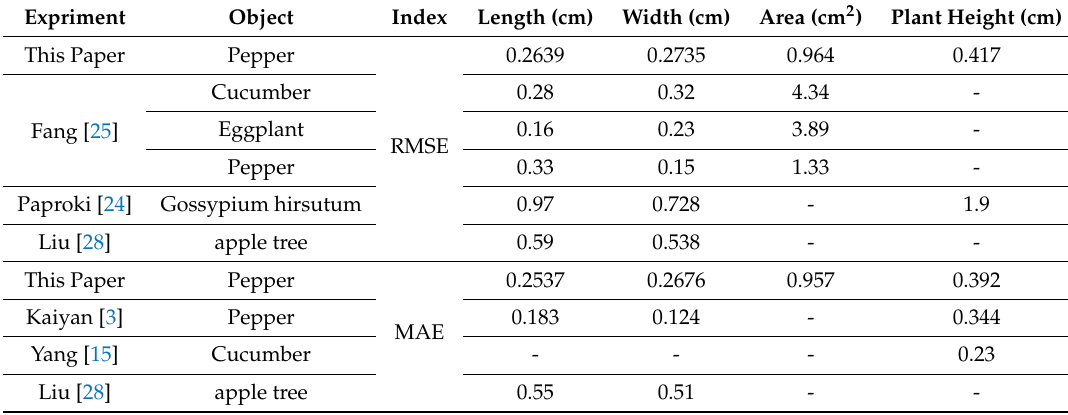
Table 1. MAE, RMSE between this paper and other papers in the terms of plant height, leaf length, leaf width and leaf